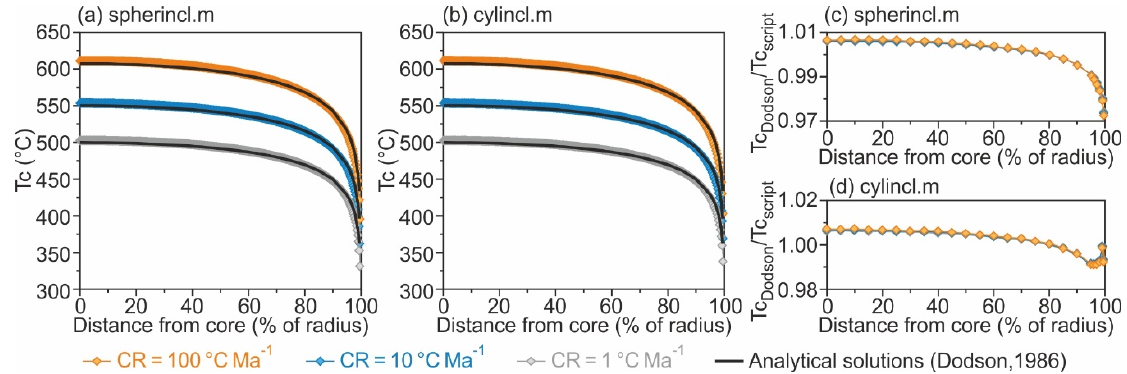
Figure 2. A comparison of the closure temperature profiles calculated for spherical crystals with radii of 150 μ m using our MATLAB scripts and Dodson’s equation [2]. ( a , b ) Absolute values for closure temperatures obtained using spherincl.m and cylincl.m, respectively. ( c , d ) The ratios between the theoretical values for closure temperatures calculated using Dodson’s equation [2] and those obtained using our MATLAB scripts. CR: cooling rate.